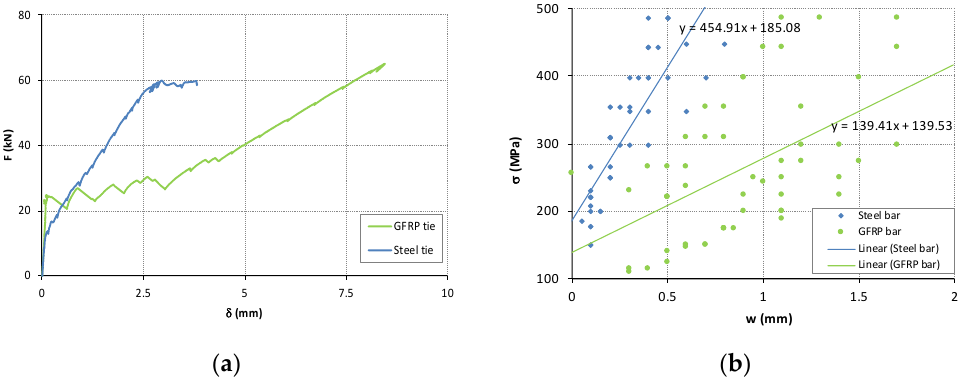
Figure 6. ( a ) Comparison between of ties reinforced with steel and GFRP rebars; ( b ) Correlation between the reinforcement stress and the cracks width.